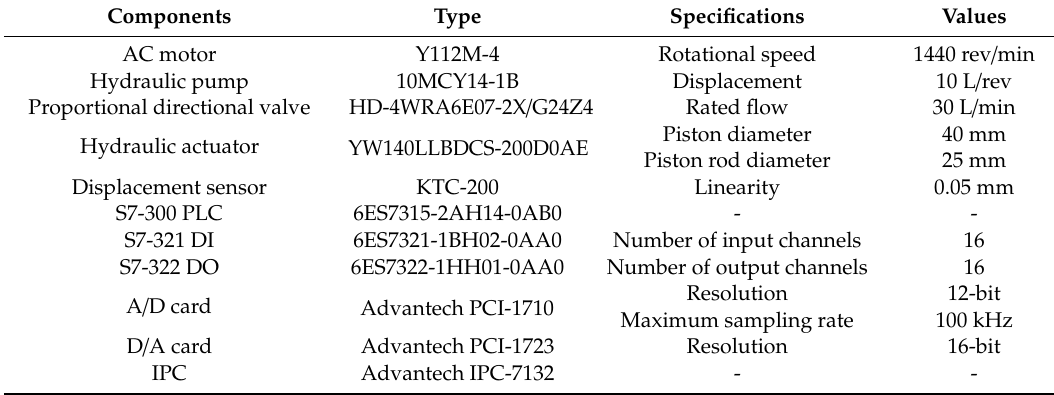
Table 2. Hardware components specifications of the test platform.